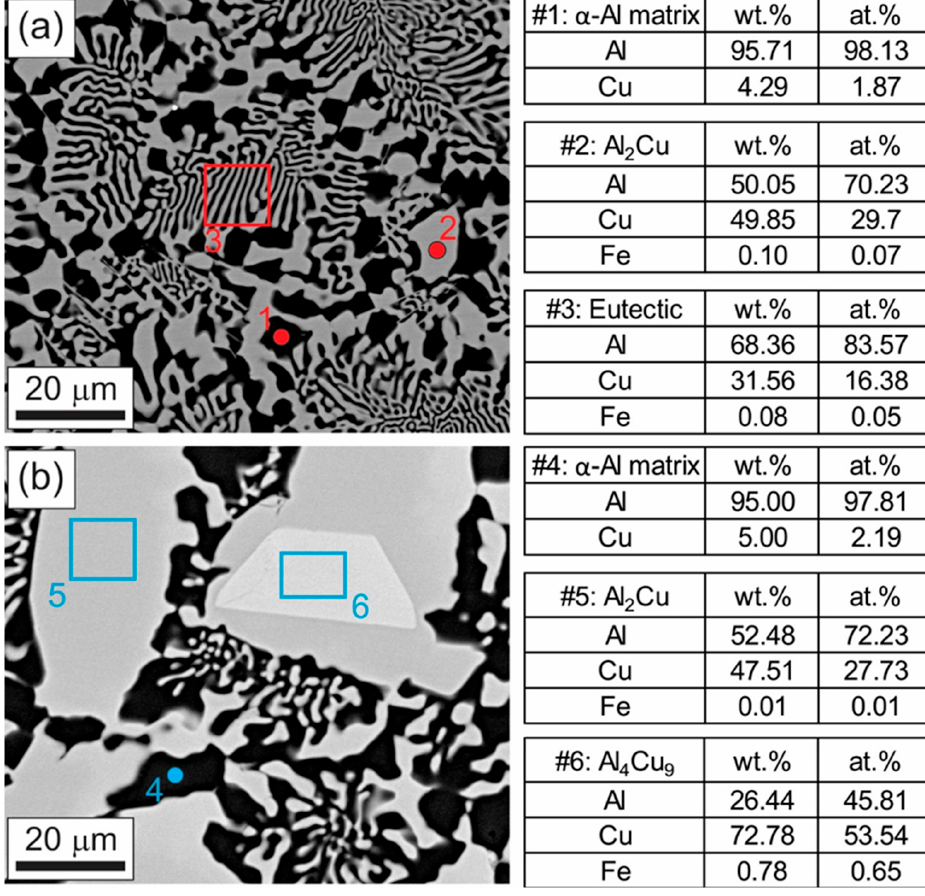
Figure 11. Elemental SEM-EDS analyses in transverse sections of the ( a ) Al-33 wt.%Cu-0.05 wt.%Be and ( b ) Al-33 wt.%Cu-0.5 wt.%Be alloys (P = 70 mm).